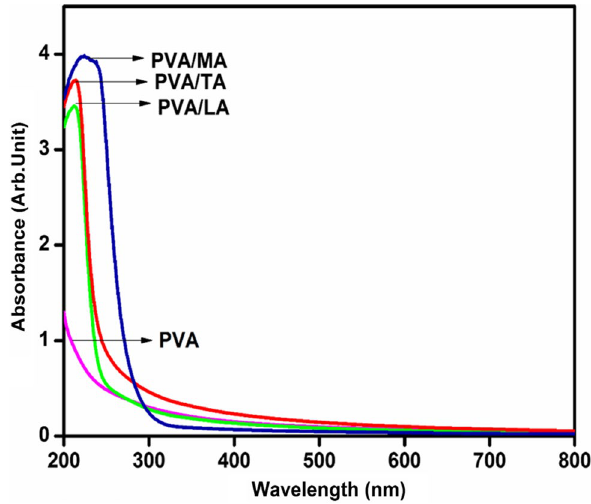
Fig. 6 UV–visible absorption spectra for pristine PVA and cross- linked PVA